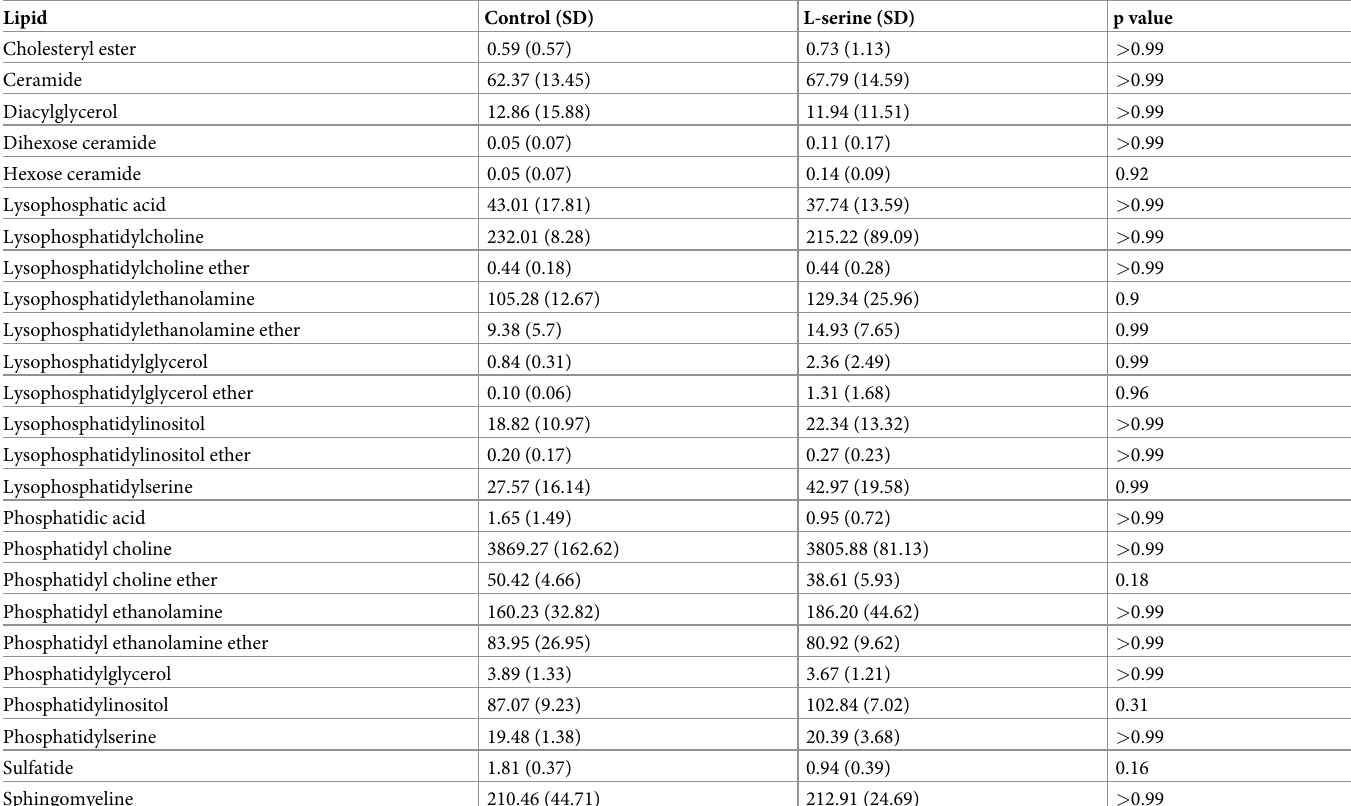
Table 1. Pancreas lipid